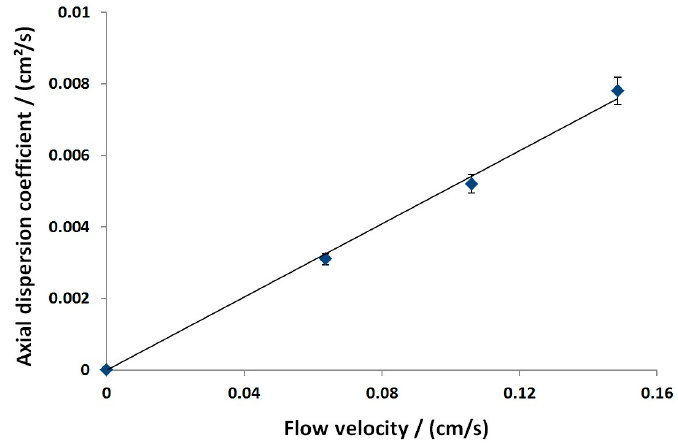
Figure 4. Dependency of the axial dispersion coefficient on the flow velocity. Buffer: 10 mM KPi, pH = 6, 20 mM NaCl.